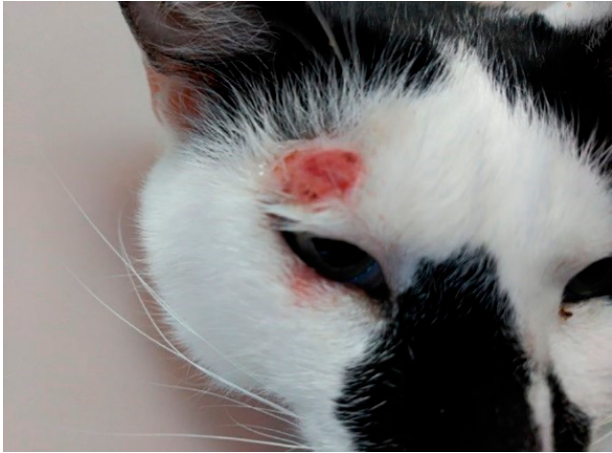
Figure 1. Ulcerative lesion in the temporal area of head related to L. infantum feline infection. Actually, clinical signs in cats could be due to co-infection with immunosuppressive disease such as cancer or viruses infection [38,42]. Thus, feline immunodeficiency (FIV) or feline leukemia (FeLV) viruses may favor the development of FL. Correlation with leishmaniosis has not been demonstrated yet in cats, although a correlation with similar pathologies as HIV in humans and dogs is well documented [70,75,76]. Different prevalence of L. infantum infection in dogs and cats agrees with the fact that cats seem to present low reaction to parasites [61]. Co-infections with Hepatozoon felis (protists) and Candidatus mycoplasma haemominutum (bacteria) have been also reported [59] (Table 1). Other diseases that can be related with the improvement in the detection of clinical signs of FL are carcinomas, for which correlation in humans and dogs has been demonstrated [77]. Maia et al. (2015) presented for the first time a clinical report of FL associated with an invasive squamous cell carcinoma in a cat [24].